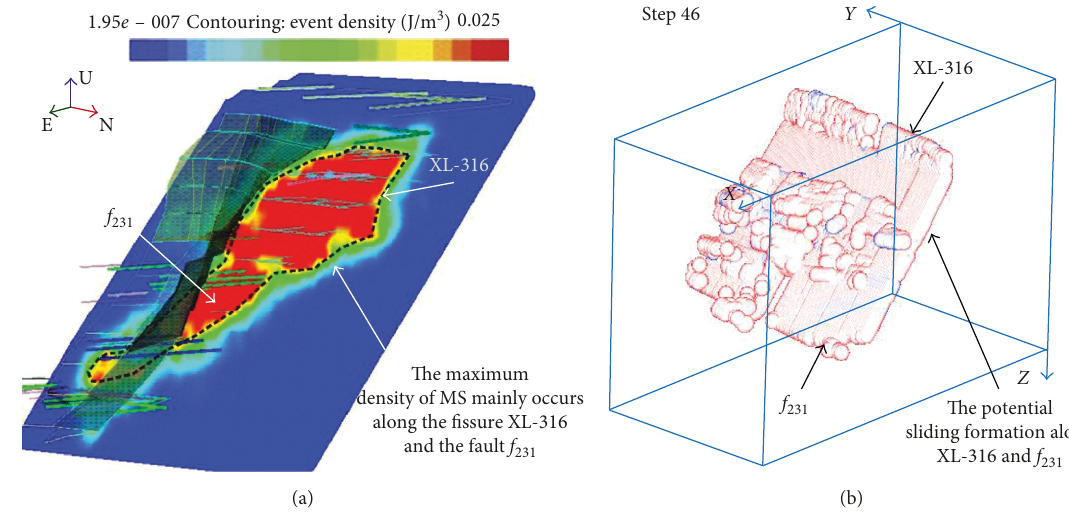
Figure 13: Correlation between the MS monitoring results and numerical simulation results for the right bank slope during excavation: (a) spatial MS events and (b) AE distribution obtained by RFPA 3D .